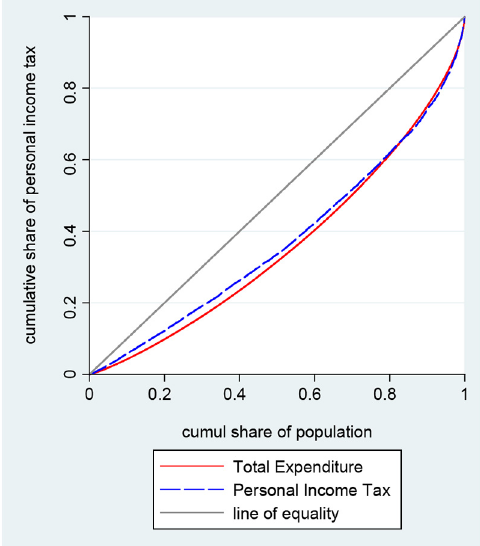
Figure 6. Concentration